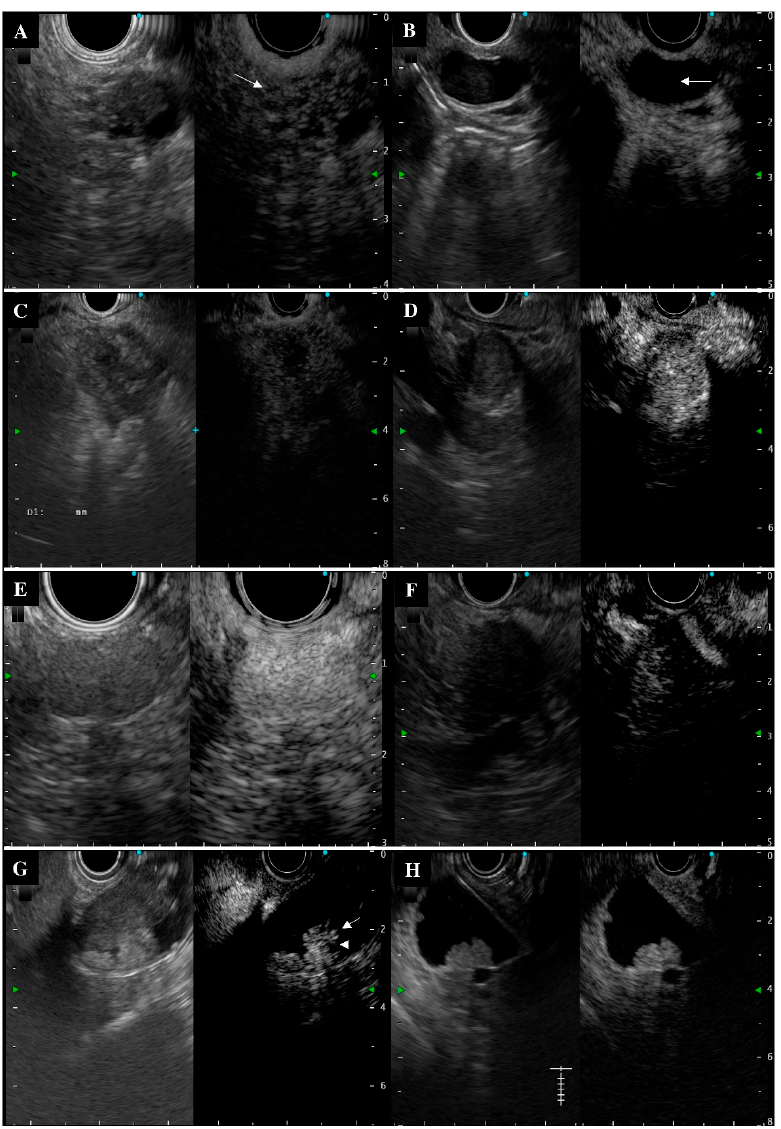
Figure 2. Typical and atypical contrast-enhanced harmonic endoscopic ultrasonography (CH-EUS) imaging of the biliopancreatic lesions (Left: fundamental B mode as a monitor image; Right: CH- EUS mode). ( A ) Typical intraductal papillary mucinous carcinoma imaging with hyperenhance- ment and a heterogenous pattern of the mural nodule (white arrow, 120 s after contrast infusion). Pathologic diagnosis by surgery: intraductal papillary mucinous carcinoma, invasive. ( B ) Typical intraductal papillary mucinous adenoma imaging with an avascular enhancement of mucinous clot (white arrow, 40 s after contrast infusion). This patient was followed up every 6 months for 15 months and with no signs of malignancy at the end of the follow-up period. ( C ) Typical pancreatic cancer imaging with hypoenhancement and a heterogenous pattern (60 s after contrast infusion). Pathologic diagnosis by surgery: pancreatic ductal adenocarcinoma. ( D ) Atypical pancreatic cancer imaging with a hyperenhancement pattern (90 s after contrast infusion). Pathologic diagnosis by